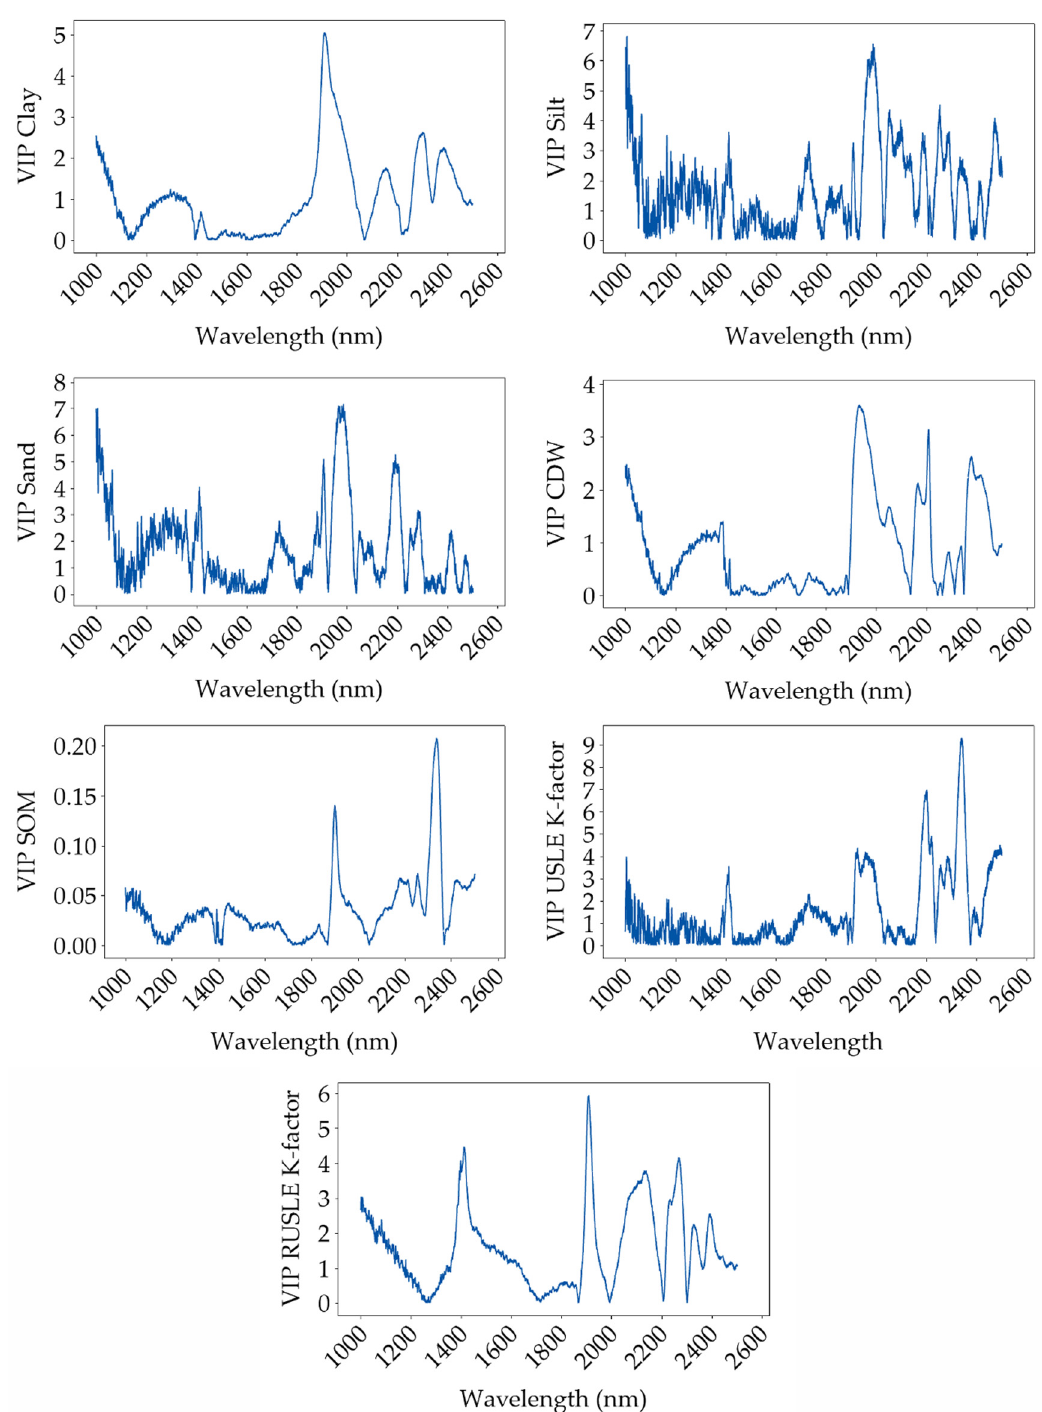
Figure 7. Variable importance for projection (VIP) plots of the studied attributes.